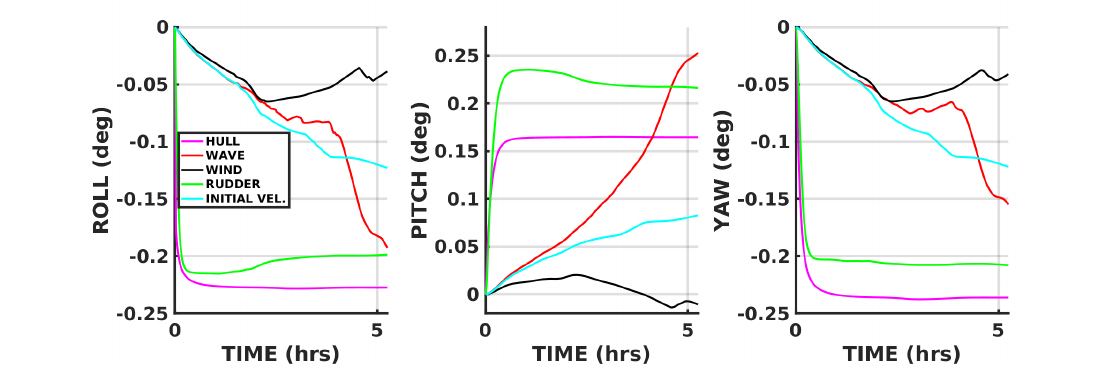
Figure 6. Rotational movements performed by the